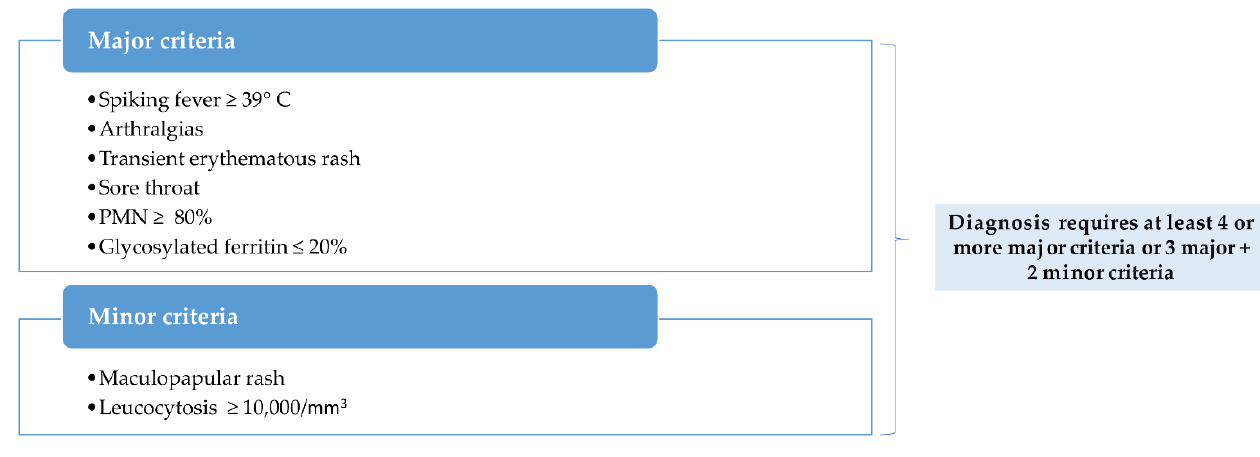
Figure 2. Fautrel criteria for AOSD (2002).